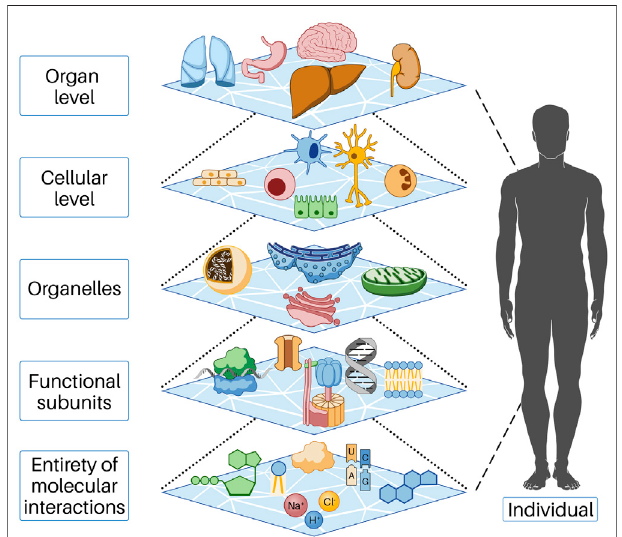
FIGURE 1 | In the cell, functions occur as a result of the collective action of many molecular parts interacting and reacting with each other. These collective properties (emergence) are an essential feature of biological systems, as understanding the individual parts alone is insuf fi cient to understand or predict system behavior. Emergent properties thus necessarily arise from the interactions of the individual parts of the system under consideration. Each of the levels shown above represents the individual parts of the next higher level. This behavior is based on mechanisms of self- organization and is only possible because energy fl ows permanently into the open system, predominantly as chemical